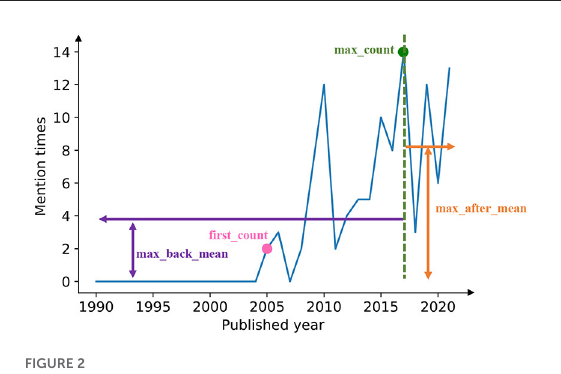
FIGURE2 Four characteristic numbers defined for time series. For each mention time series, we extracted four characteristics to represent the time series, as shown in the figure: max_back_mean, first_count, max_count, max_after_mean.